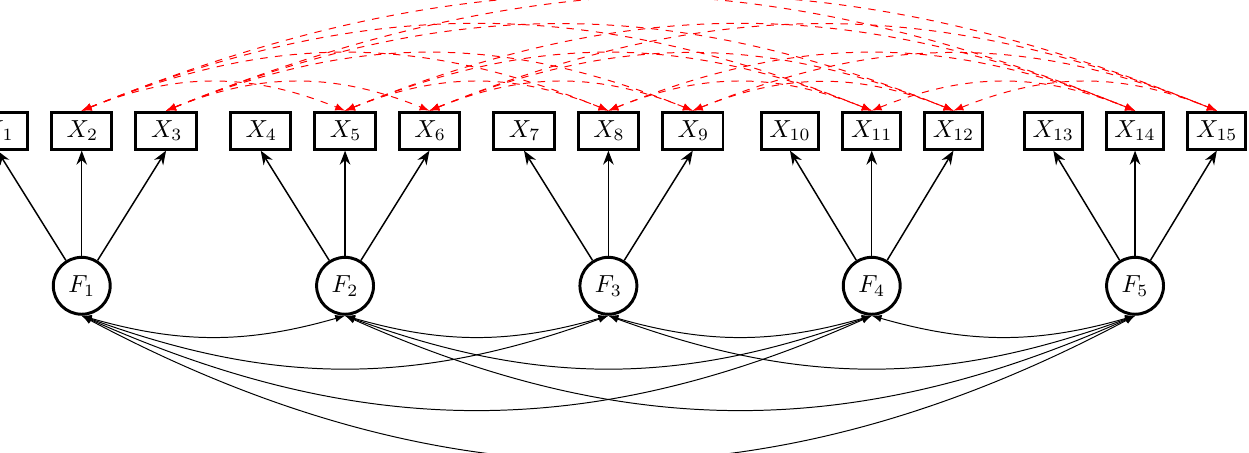
Figure 9. Simulation Study 4: Data-generating model with residual correlations (DGM3). Residual correlations are displayed with curved dashed red double